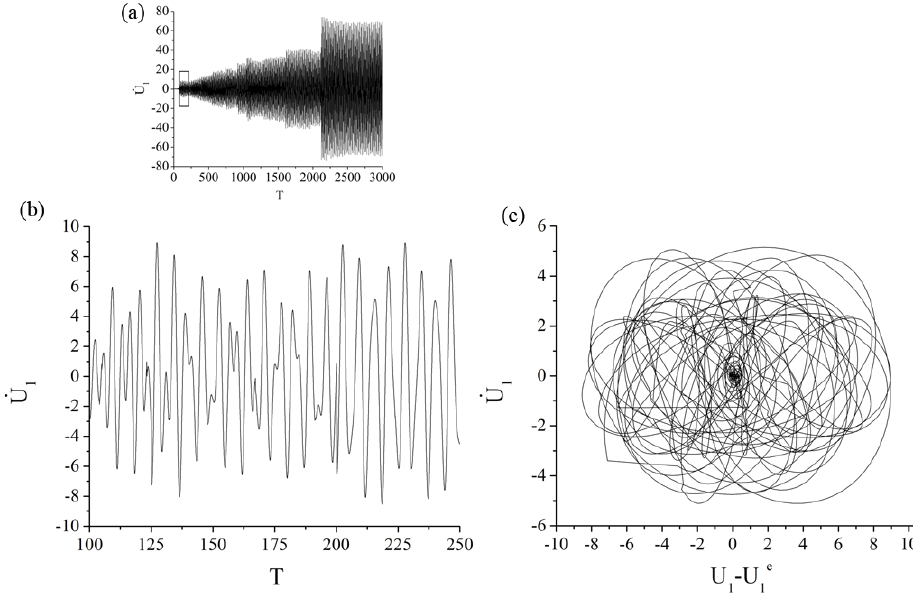
Fig. 9. Temporal evolution of variable ˙ U 1 (b) and corresponding phase portrait (c) for c 1 = 0.2, τ 1 = 0.5 c 2 = 0.2 and τ 2 = 3. In the uncou- pled case, ( c 1 , τ 1 ) would warrant the oscillatory motion of the first block, whereas ( c 2 , τ 2 ) would hold the other block at the equilibrium. = υ c = k = k = k = 1. The time series over a long simulation period is shown in (a) , where the The remaining parameter values are: υ c 1 2 1 2 chaos-like region is marked with the rectangle. It is apparent that the system eventually converges to quasiperiodic behavior.